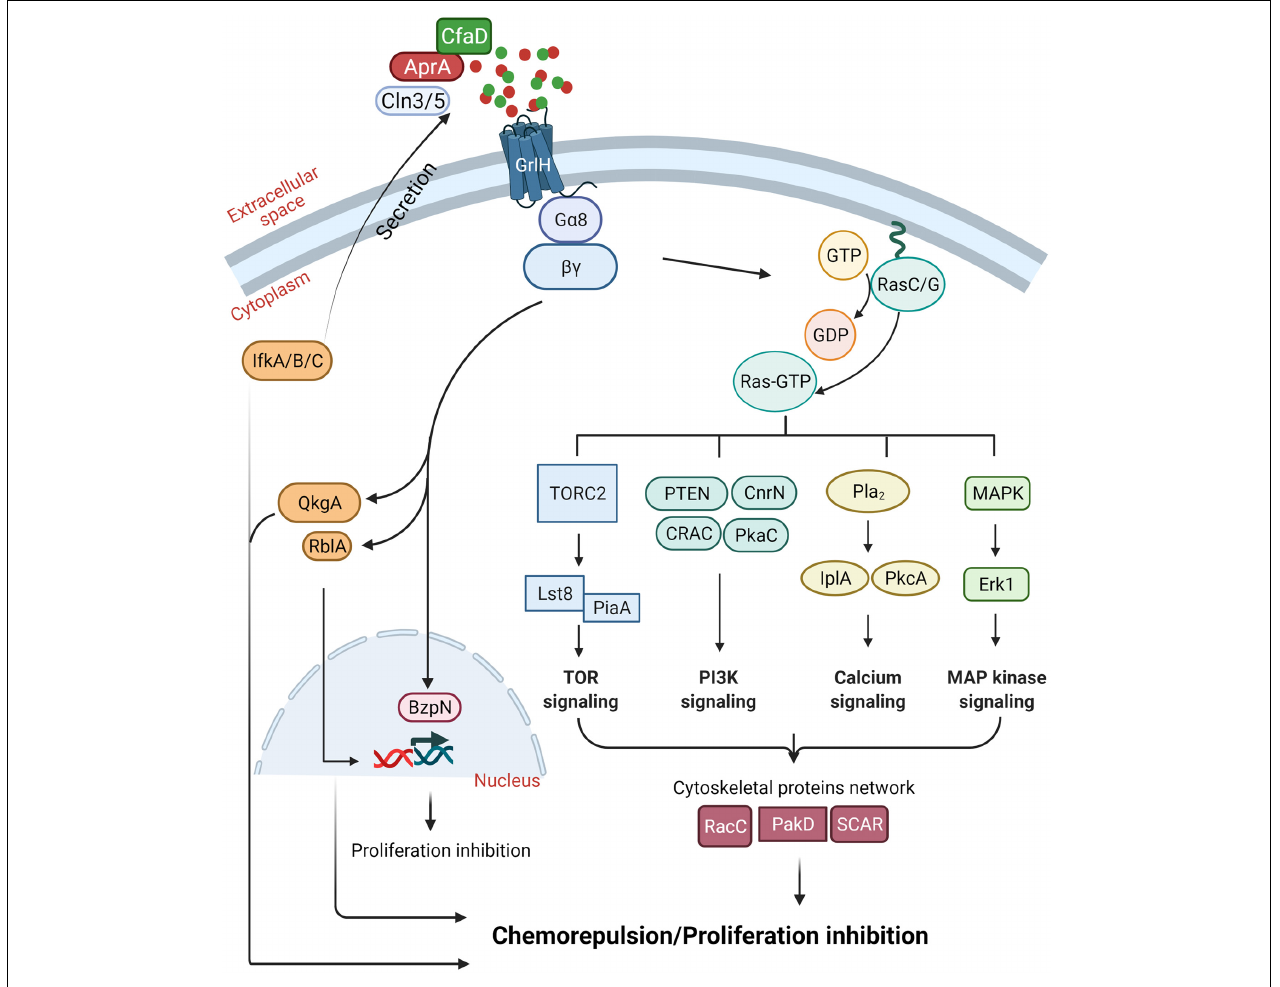
FIGURE 3 | Summary of our current understanding of the AprA signal transduction pathway. See text for details. Figure created with